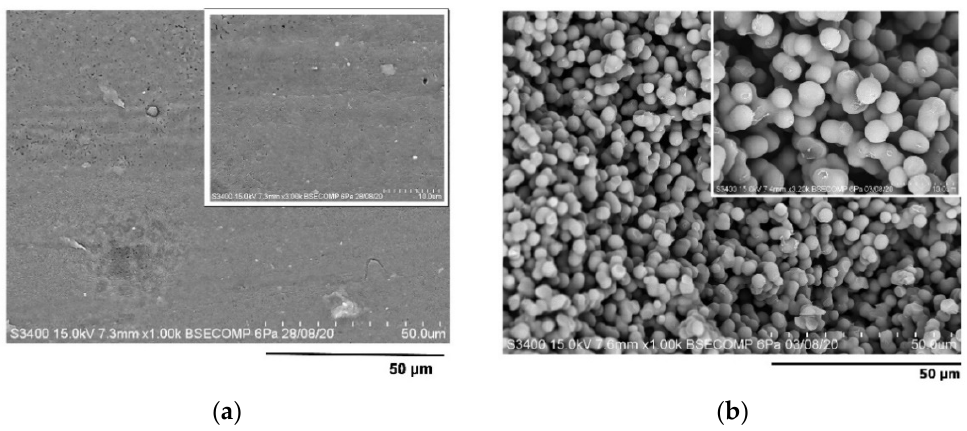
Figure 6. SEM images of monolith ( a ) without template and ( b ) with template.